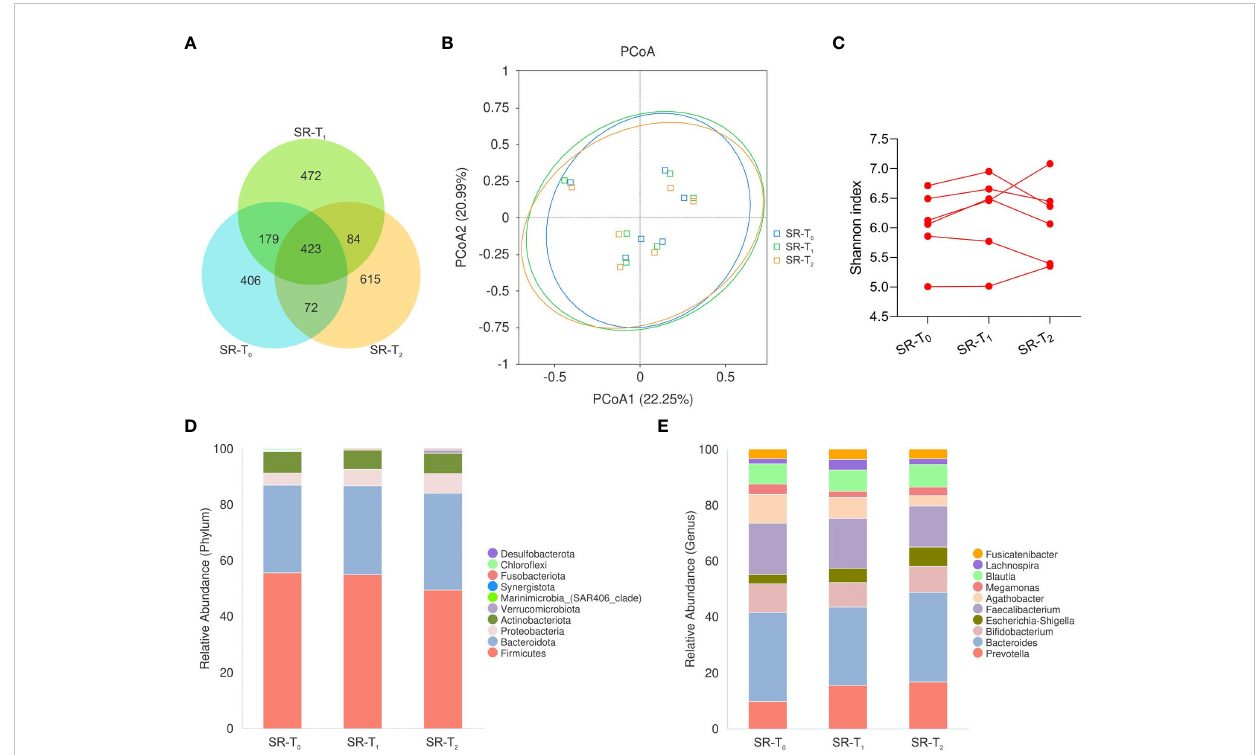
FIGURE 3 The longitudinal intestinal microbiota of patients with secondary resistance to ICIs. Fecal samples were sequentially collected from baseline (SR-T 0 ) to primary response (SR-T 1 ), to secondary resistance (SR-T 2 ) in patients with secondary resistance. (A) Venn diagram of ASVs; (B) PCoA plot using Bray-Curtis distances; (C) Individual a -diversity by Shannon index; (D) Histogram of intestinal microbiota relative abundance with top 10 phyla; (E) Histogram of intestinal microbiota relative abundance with top 10 genera. ASVs, amplicon sequence variants; PCoA, principal coordinates analysis; SR-T 0 , secondary resistance patients - before ICI treatment; SR-T 1 , secondary resistance patients - primary response after ICI treatment; SR-T 2 , secondary resistance patients - secondary resistance after ICI